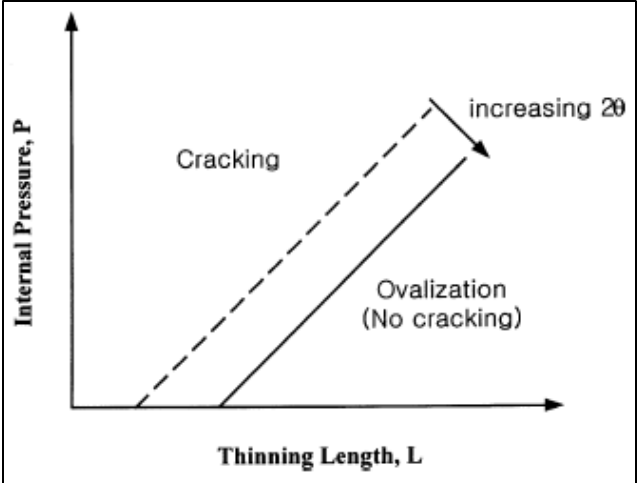
Figure 5. A conceptual visualization of the effects of the axial length of the corrosion defect area and internal pressure on pipe on the crack occurrence in the corrosion defect area is shown. Note that 2 θ symbolizes the width of the defect [58].